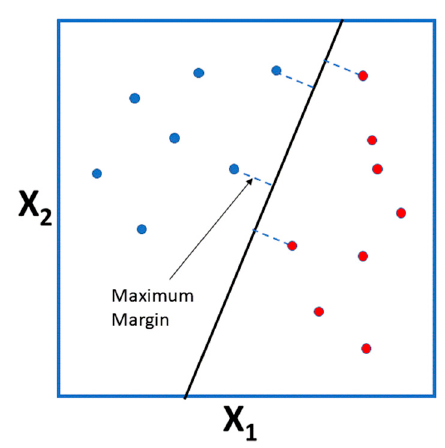
Figure 4. Maximum margin hyperplane for a predictor space of two variables. Two categories are perfectly classified by this hyperplane. The hashed lines indicate the maximum margin to the training set, obtained with this particular hyperplane. Training instances are presented as points in the plane, blue points corresponding to class “ + ” and red points to “ − ”. The points located at a maximum margin to the hyperplane are the support vectors , since the plane only depends on these points of the training set.